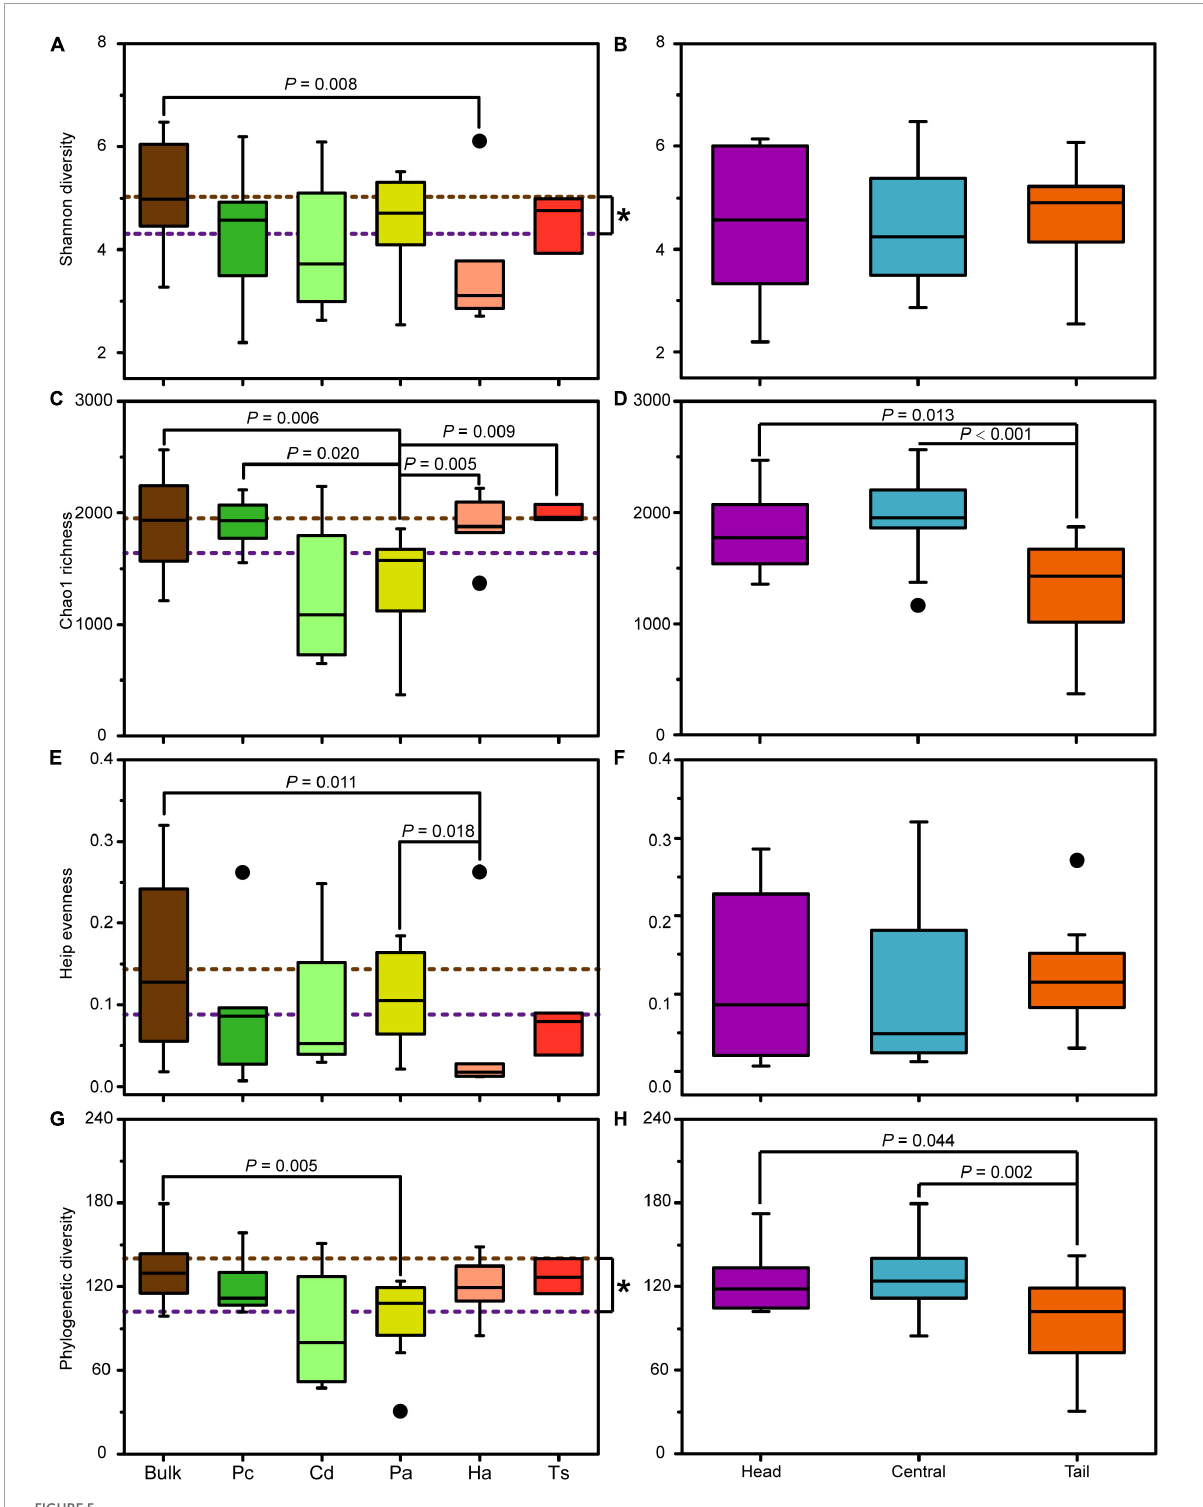
FIGURE5 Alpha diversity indices of bacterial communities in bulk and rhizospheric soils (A,C,E,G) , and in bulk soils from the head, central, and tail part of the MCB (B,D,F,H) . Pc, P. communis ; Cd, C. dactylon ; Pa, P. arundinacea ; Ha, H. altissima ; Ts, T. sacchariflora . The brown and purple dotted lines: the mean value of community diversity in bulk and rhizospheric soils, respectively. The P values with significant differences at 0.05 level based on nonparametric Mann–Whitney U tests are indicated above each box plot. “*” indicates the significant difference at 0.05 level based on nonparametric Mann–Whitney U